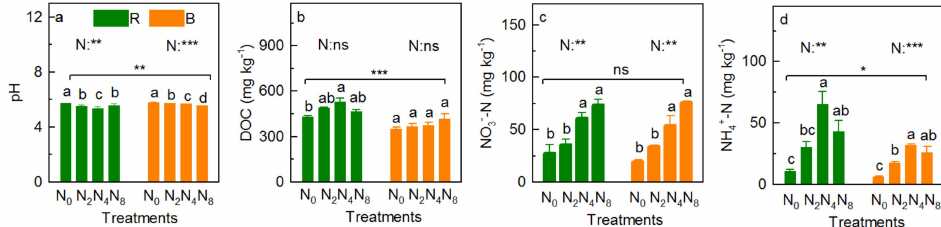
Figure 4. pH ( a ), DOC ( b ), NO 3 − -N ( c ), and NH 4+ -N ( d ) content of soil (rhizosphere and bulk) under the N addition rates. p -value of the ANOVA of N addition treatments (0, 20, 40, and 80 kg N ha − 1 y − 1 ) on soil compartment (rhizosphere and bulk soils) is indicated: * p ≤ 0.05; ** p ≤ 0.01; *** p ≤ 0.001; ns, not significant.